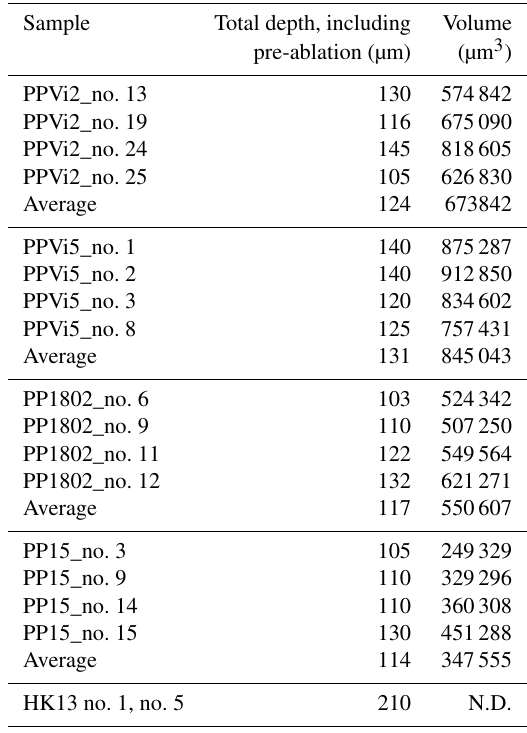
Table A5. Statistical analysis of crater depths induced by laser ab- lation for U–Pb dating by an optical profilometer. The total crater depths and volumes include the 7s pre-ablation (N.D. – not deter-